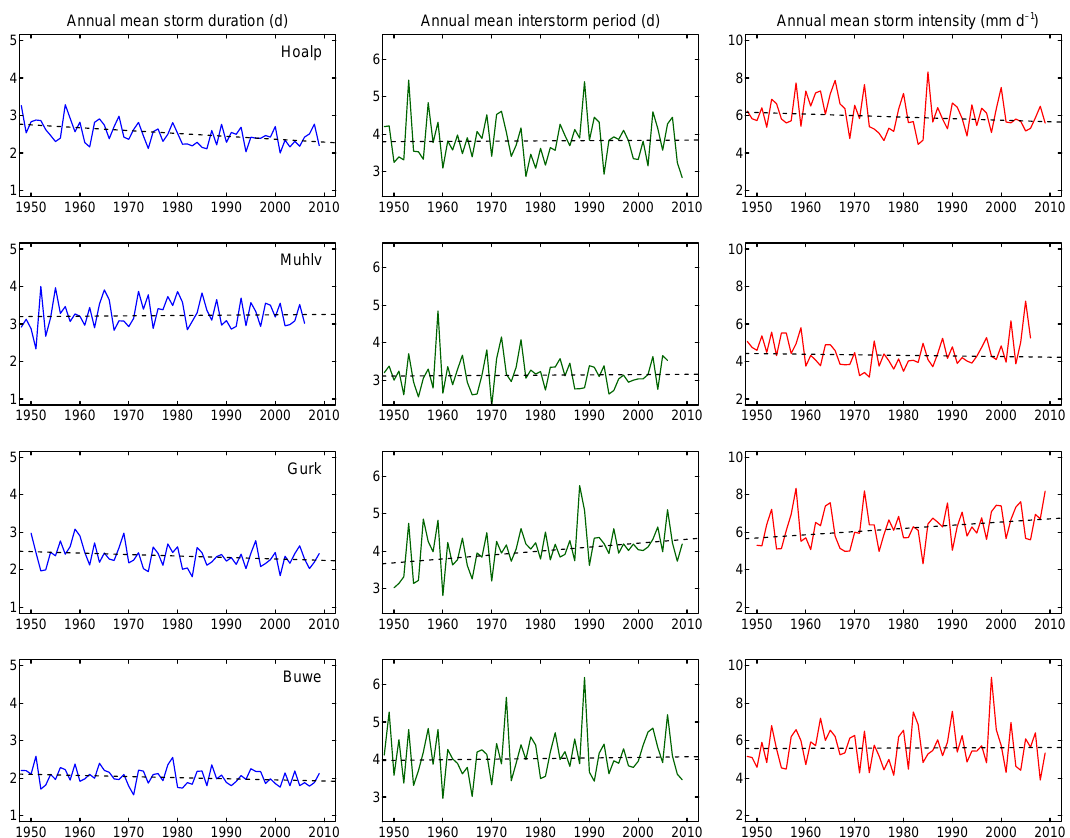
Figure 7. Observed trends in the precipitation statistics for the climate stations St. Jakob Def (Hoalp), Pabneukirchen (Muhlv), Klagenfurt (Gurk) and Wöerterberg (Buwe). The trend lines (dashed) have been fitted with the Theil–Sen